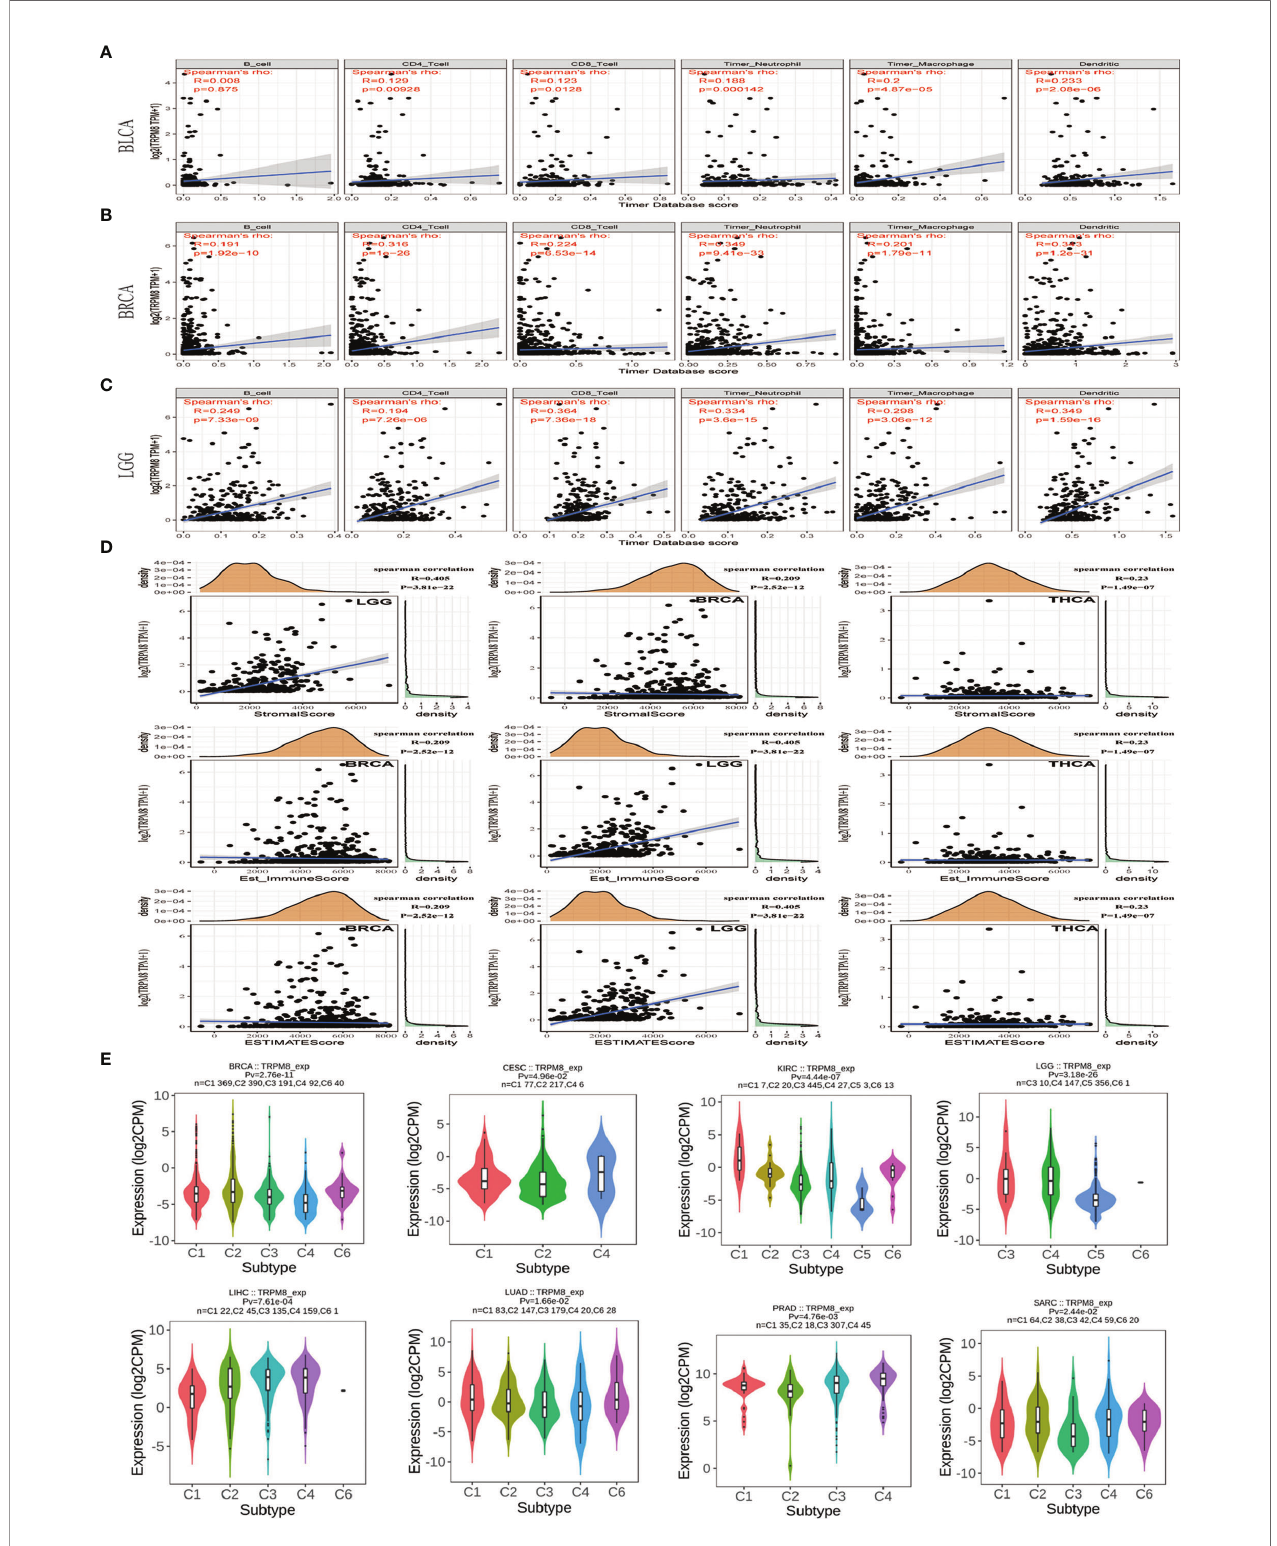
FIGURE 6 | Associations between TRPM8 and immune in fi ltration in different tumors. (A) BLCA. (B) BRCA. (C) LGG. (D) Correlation between TRPM8 and immune score, stromal score, and estimate immune score. (E) TRPM8 mRNA levels in different immune subtypes in BRCA, CESC, KIRC, LGG, LIHC, LUAD, PRAD, and SARC via TISIDB. C1 (wound healing); C2 (IFN-gamma-dominant); C3 (in fl ammatory); C4 (lymphocyte-depleted); C5 (immunologically quiet); C6